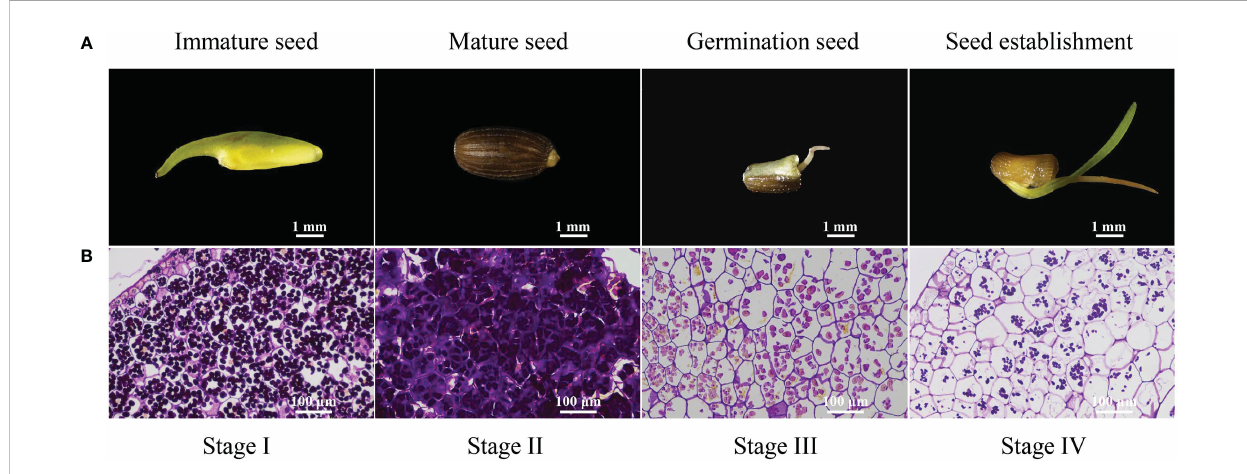
FIGURE 1 Morphology and histology of developing Zostera marina seeds. (A) Zostera marina seed at different developmental stages. (B) During Zostera marina seed development, starch was stained with PAS. The rulers indicate 1 mm in (A) and 200 m m in (B)